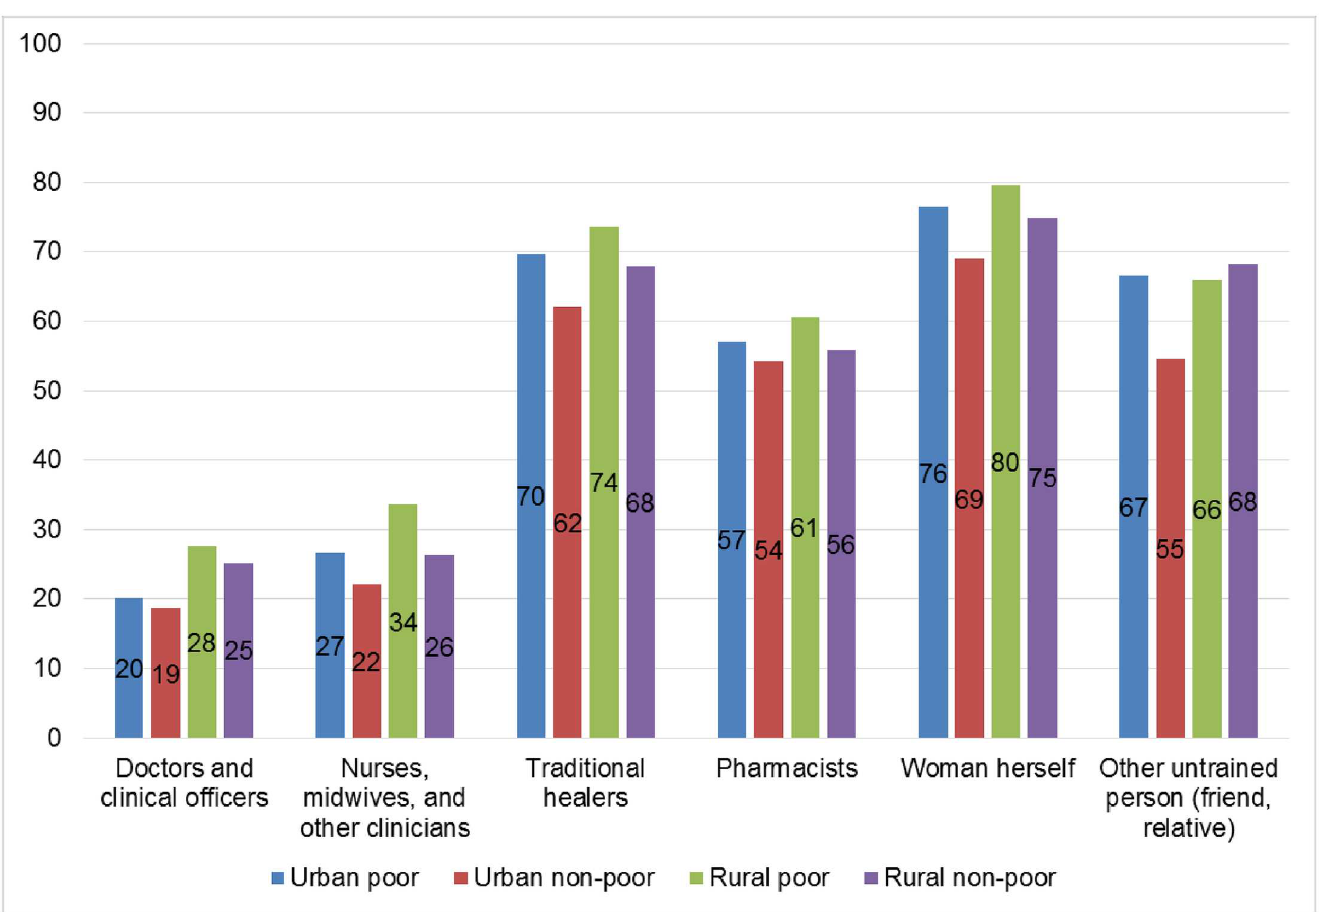
Fig 2. Proportion experiencing complications by provider type, Knowledgeable Informant Survey, Malawi 2015.